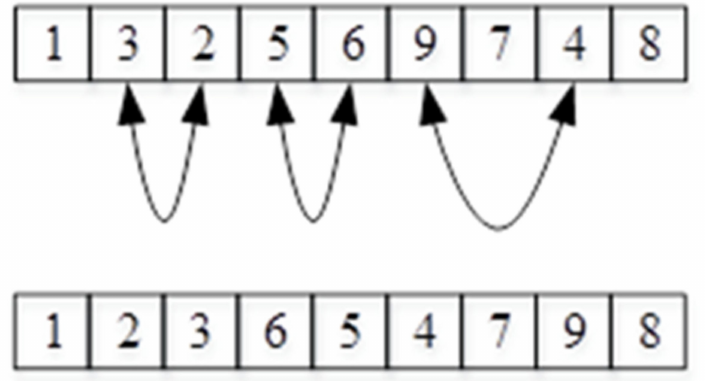
Figure 3. Mutation operator adapted to permutation coding in a 9 × 3